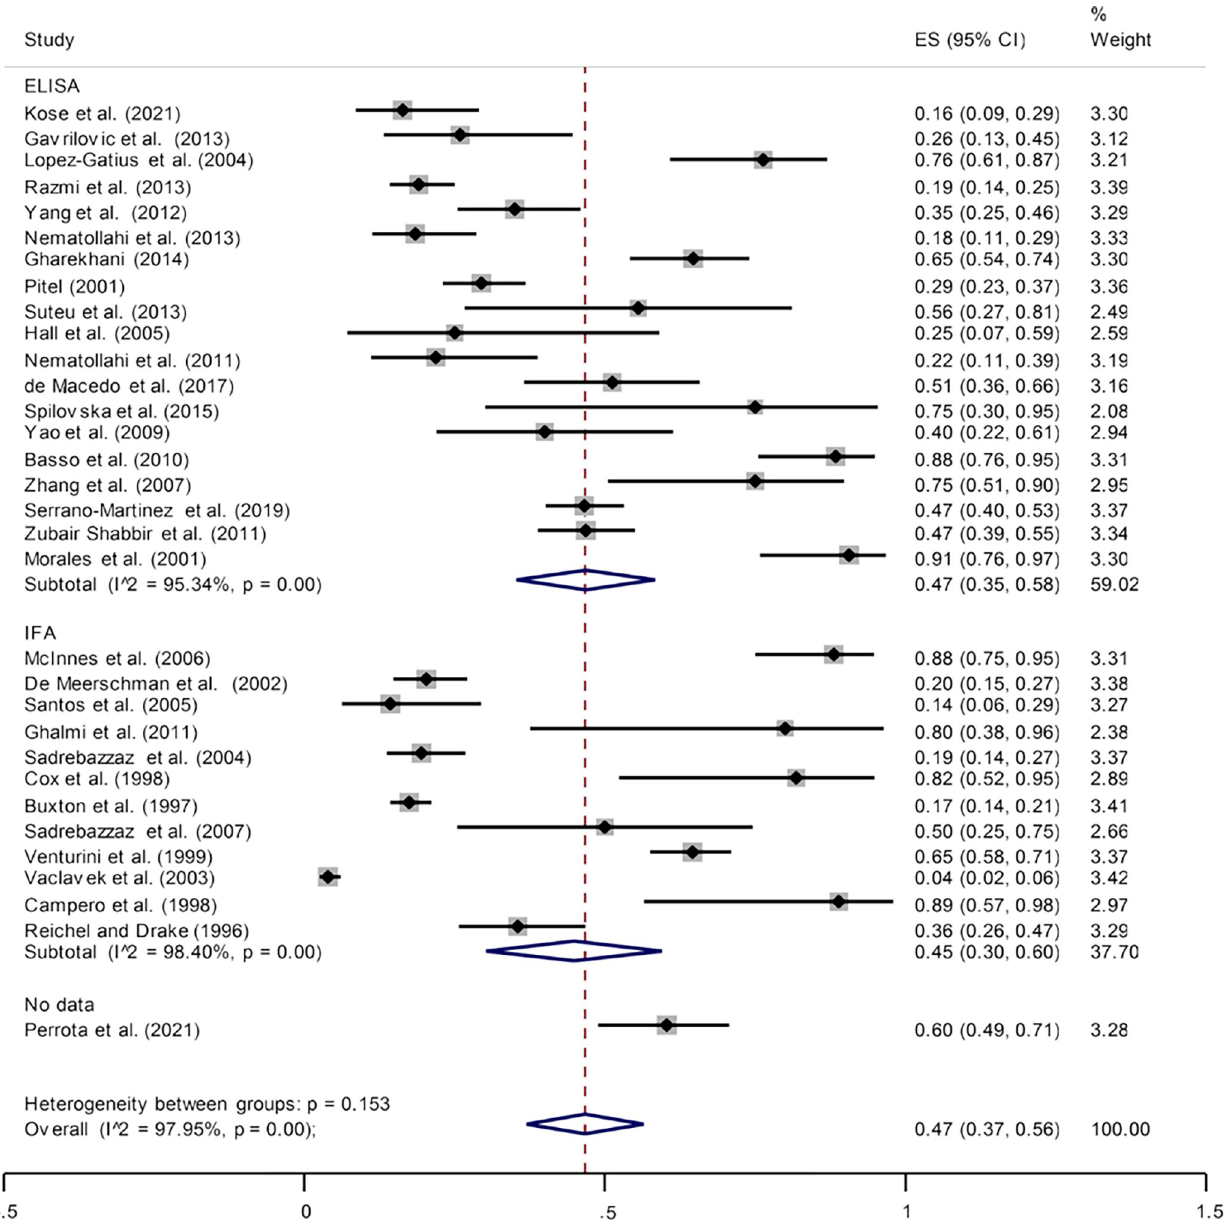
Fig 2. The reported seroprevalence rate of anti- N . caninum antibodies in bovines that had an abortion by serological